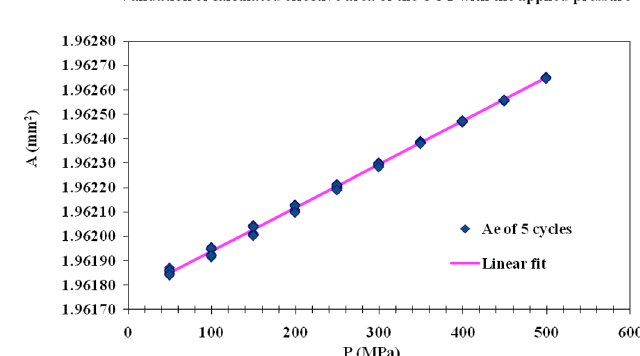
Fig. 4. Ae vs. P for UUT calibration against NIS pressure scale for 5 cycles, and linear fi t in range from 50 to 500 MPa.